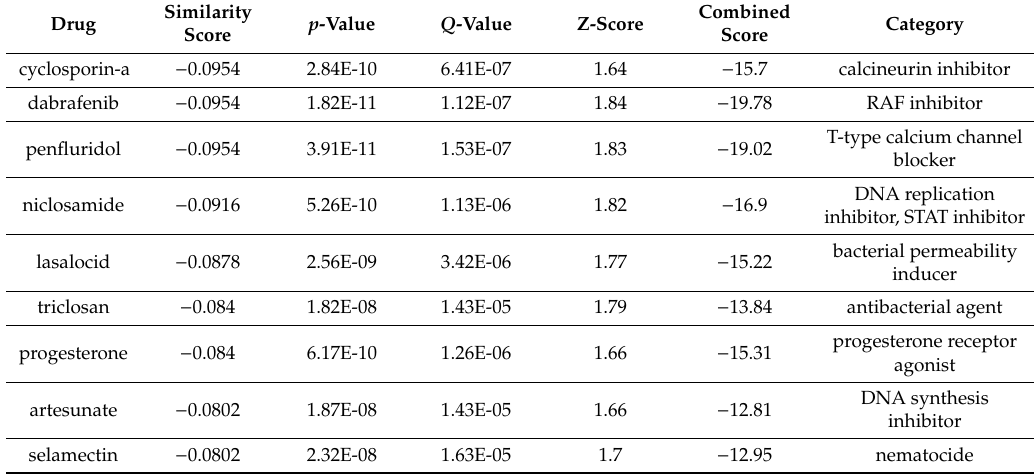
Table 4. Potential anti-AD drugs identified by the L1000FWD analysis using the iPSC-derived neuronal cells model of